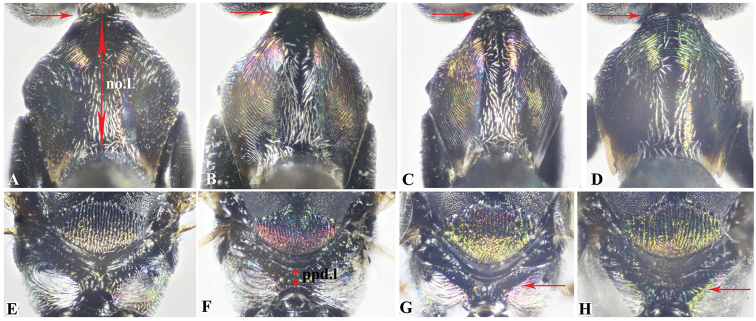
A−D Dorsal aspect of pronotum, Holotype AOodera
arabica sp. nov. BOodera
omanensis sp. nov. COodera
rapuzzii sp. nov. DOodera
similis sp. nov. E−H Mesoscutellum, metanotum and propodeum EOodera
arabica sp. nov. FOodera
omanensis sp. nov. GOodera
rapuzzii sp. nov. HOodera
similis sp. nov. (anterior margin of pronotum indicated in A−D, propodeal lateral ridge indicated in G, H).